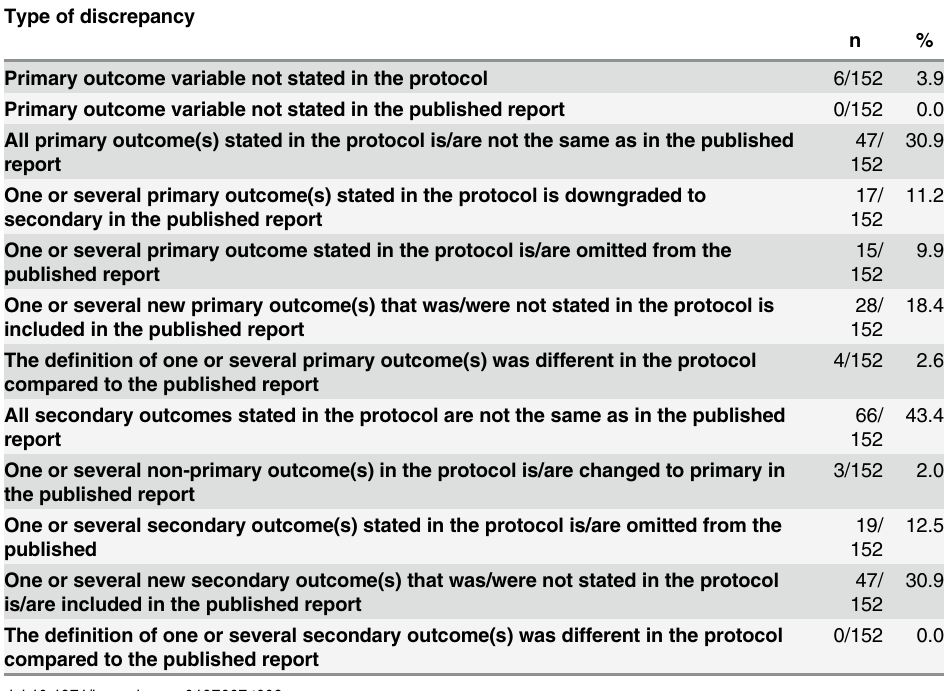
Table 3. Tabulation of type of discrepancy between protocols and reviews for primary and secondary outcomes at the review level. Type of discrepancy Primary outcome variable not stated in the protocol